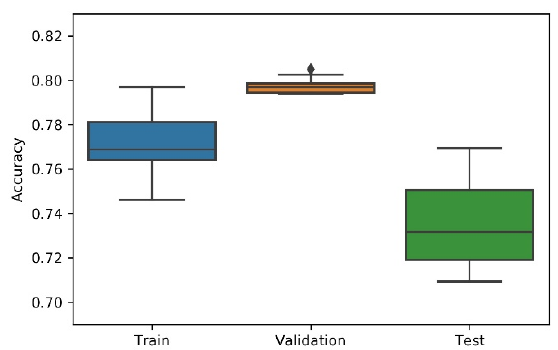
Figure 8. Experiment’s performance for Approach A2 (Bayesian) accuracy (in %).